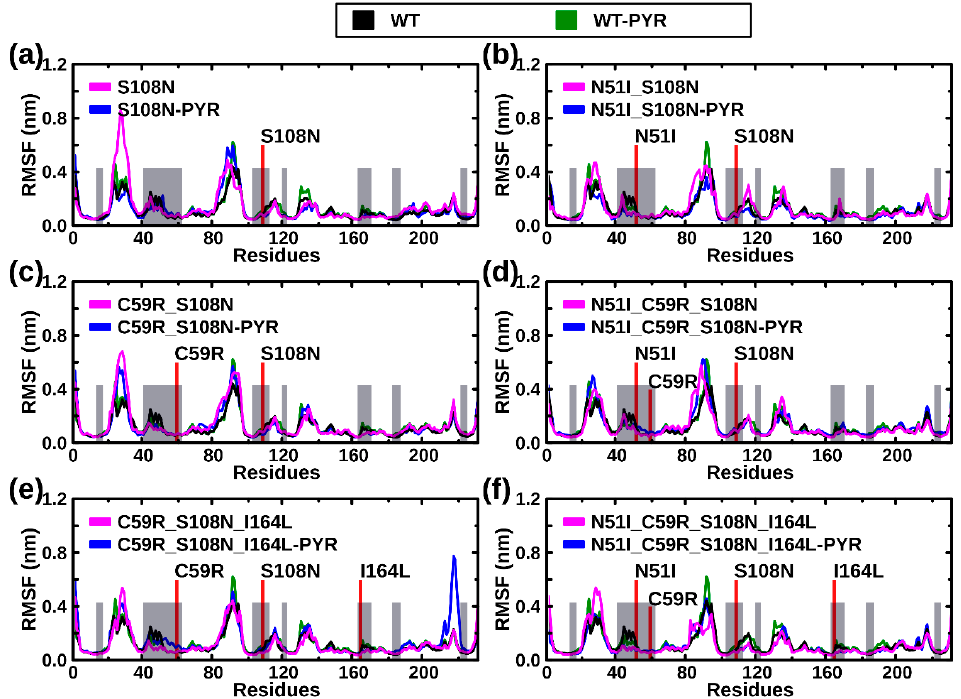
Figure 3. Average per residue root mean square fluctuation (RMSF) computed from C α atoms: ( a ) S108N, ( b ) N51I_S108N, ( c ) C59R_S108N, ( d ) N51I_C59R_S108N, ( e ) C59R_S108N_I164L, and ( f ) N51I_C59R_S108N_I164L. Color key: black: WT holo, green: WT complexed with pyrimethamine, magenta: mutant holo, blue: mutant complexed with pyrimethamine.